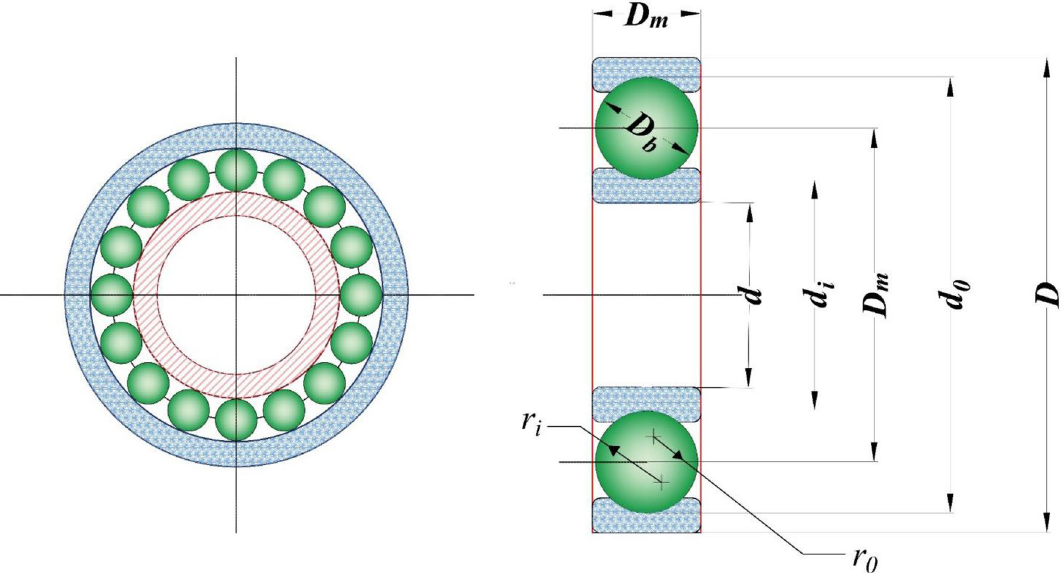
Figure 6. Schematic representation of the hydro-static thrust